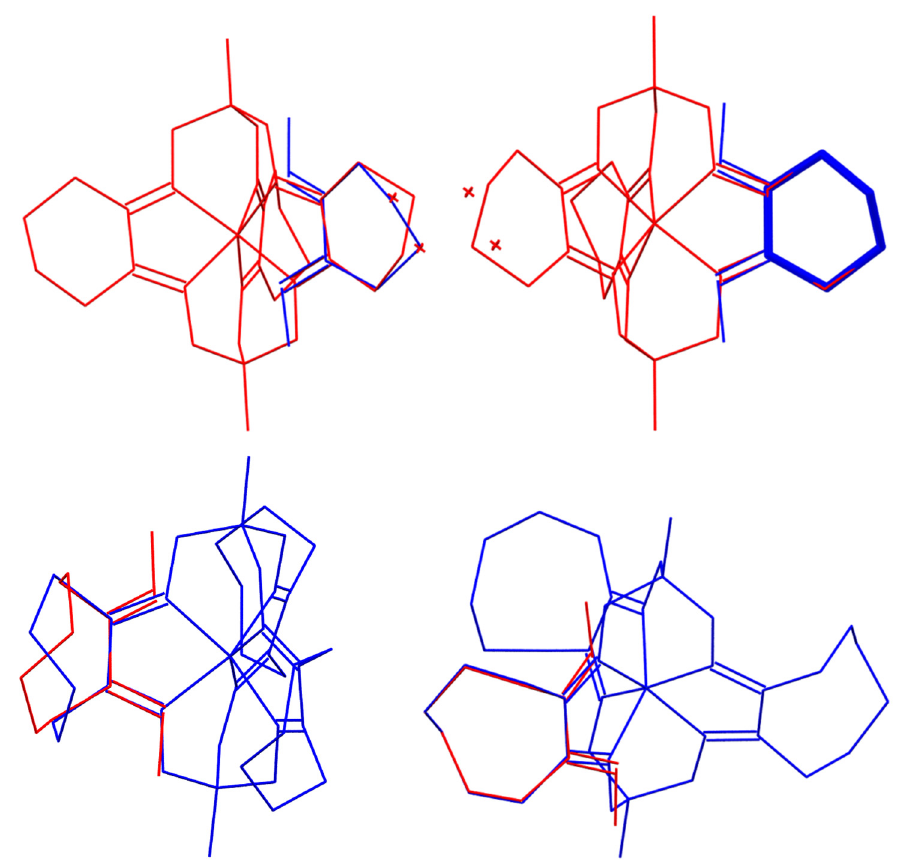
Figure 10. Comparison of a geometry of cyclohexane (on top) and cyclooctane (on bottom) alicyclic fragments in the corresponding boron-capped iron(II)-encapsulating clathrochelate molecules and the initial α -dioximes.